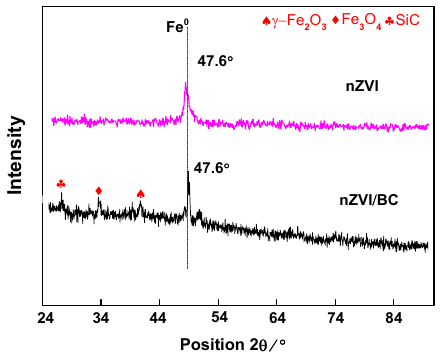
Figure 3. XRD analysis of nZVI and nZVI/BC.